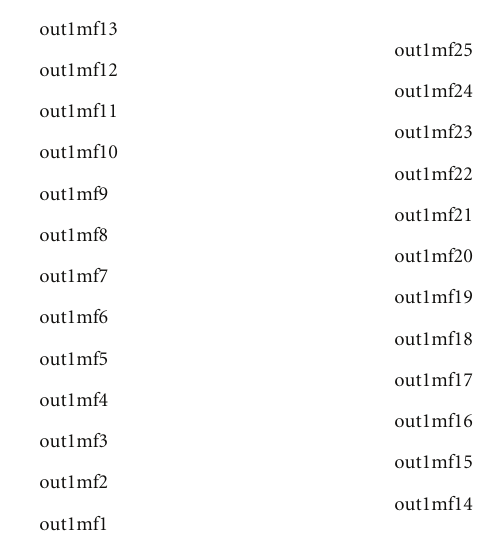
Figure 12: GA ANFIS controller output variable “ u